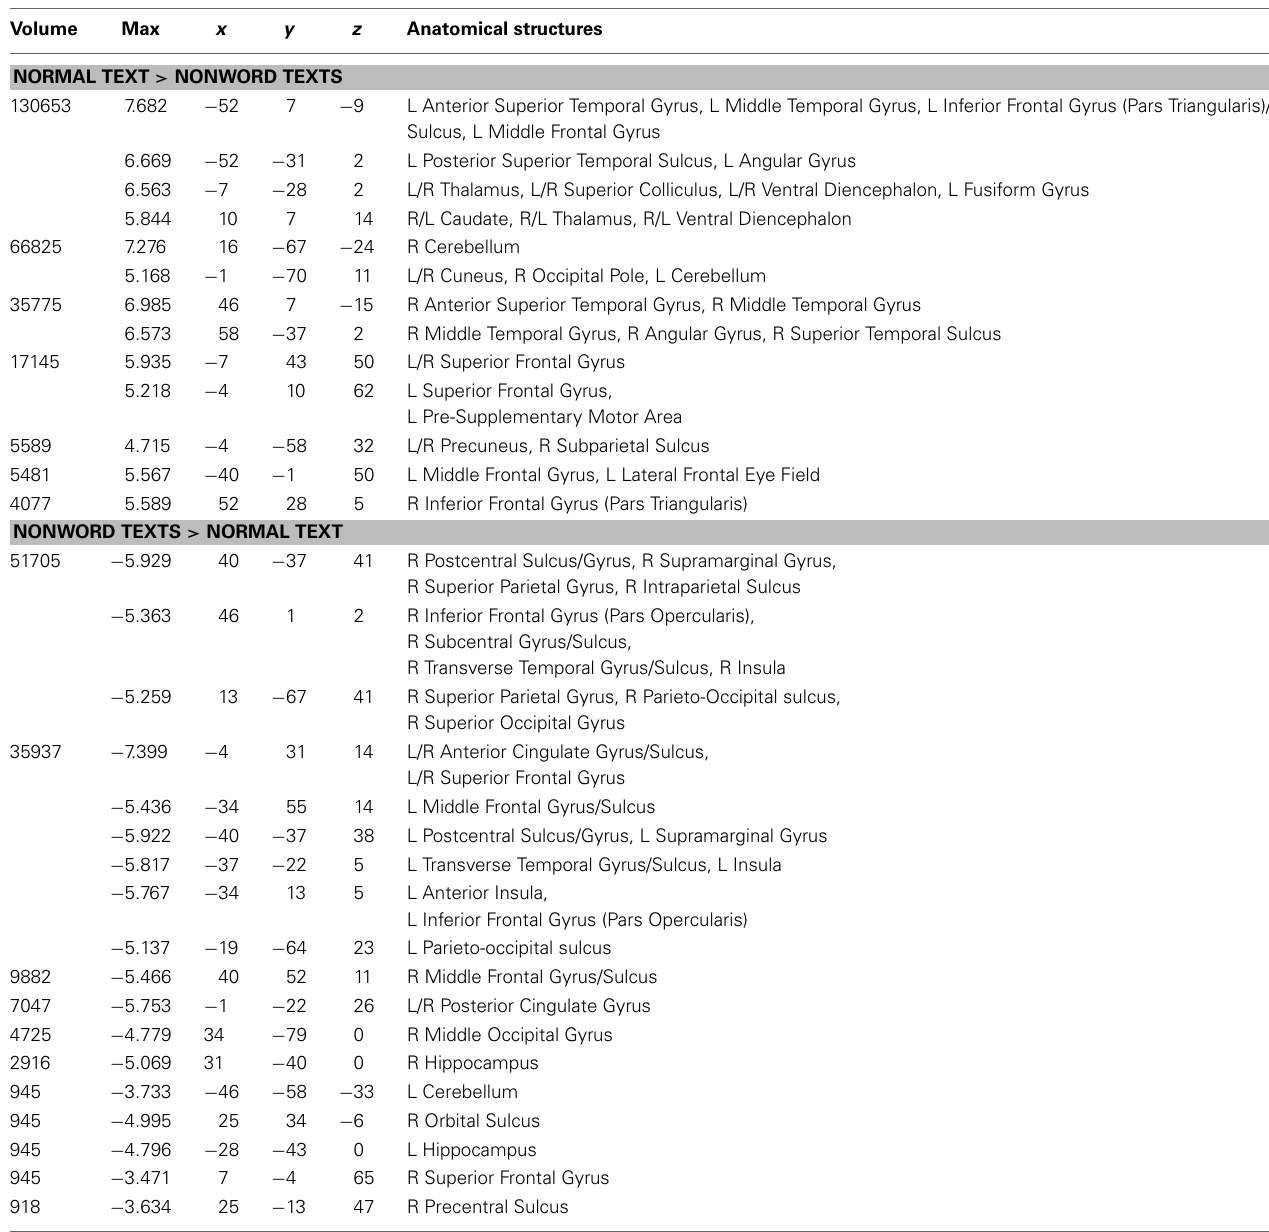
Table 5 | Talairach coordinates, volume of the cluster ( µ l), maximum z-score, and the label of anatomical structure for the normal text vs. the nonword texts analysis, L, left hemisphere; R, right hemisphere. Anatomical